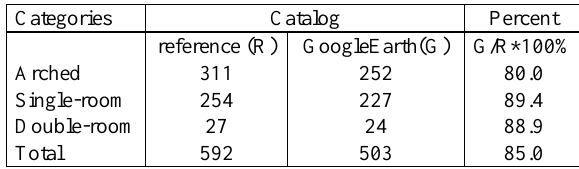
Table 1. Comparison of STWs cataloged by GoogleEarth-based method with STWs in the reference catalog.